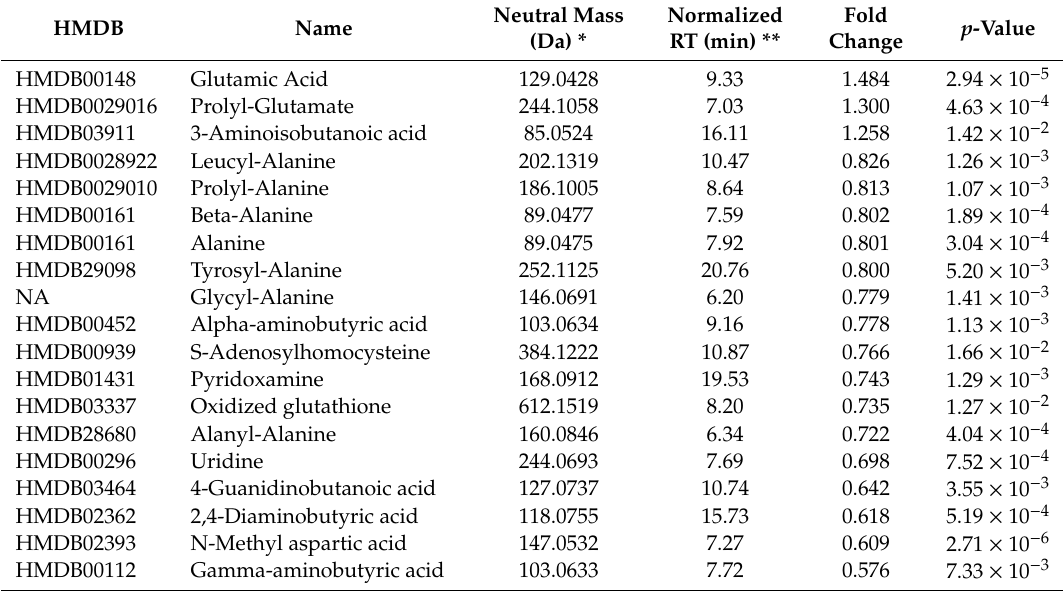
Table 4. Positively identified significantly di ff erentially expressed metabolites in the rat kidney tissue after prolonged Dex